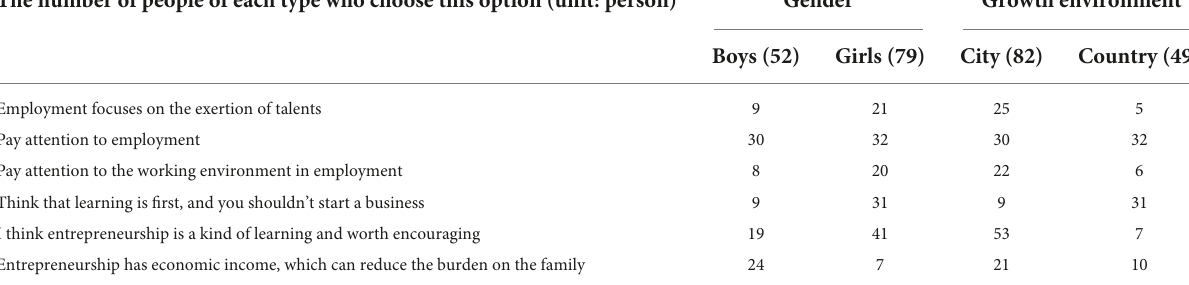
TABLE 9 Intra group comparative data on employment tendency of college students from divorced families. The number of people of each type who choose this option (unit: